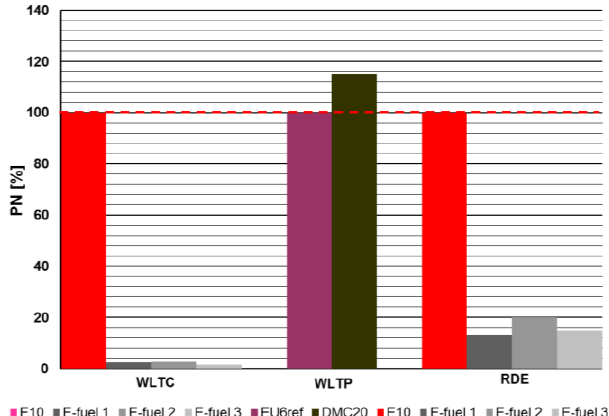
Fig. 2. Changes in the mean level of PN emissions (> 23 nm) for various synthetic fuels compared to conventional petroleum fuels measured in the